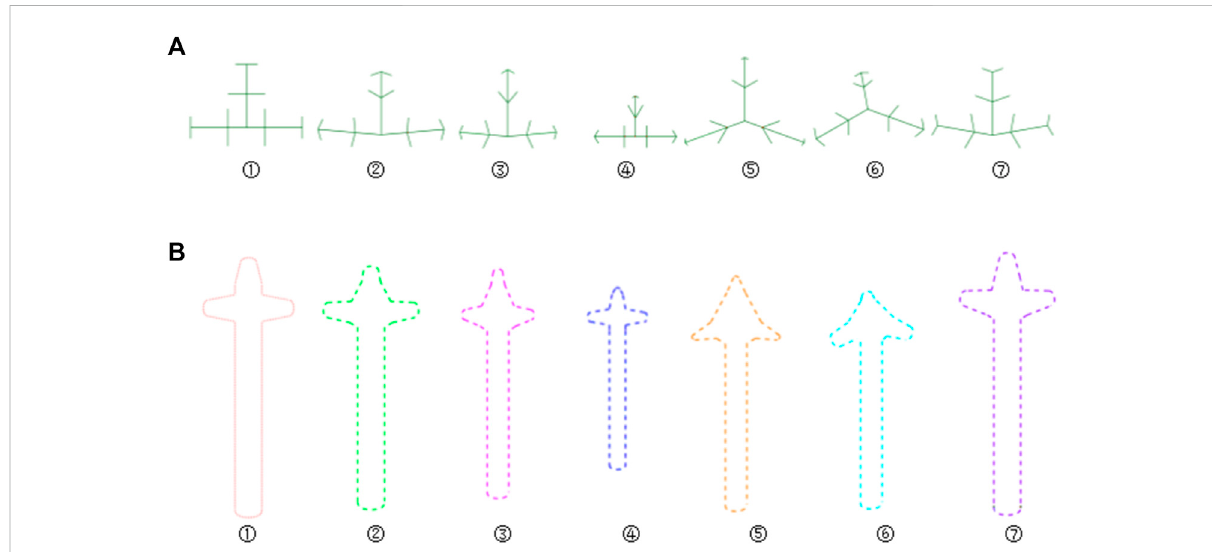
FIGURE 10 Bionicveinstructuresandsketchesofcloverboneplate. (A) Bionicveinstructuresgeneratedbysettingdifferentsemanticparametersshownin Table 1. These structures are numbered 1 through 7. (B) Feature sketches of the structures in panel (A) .